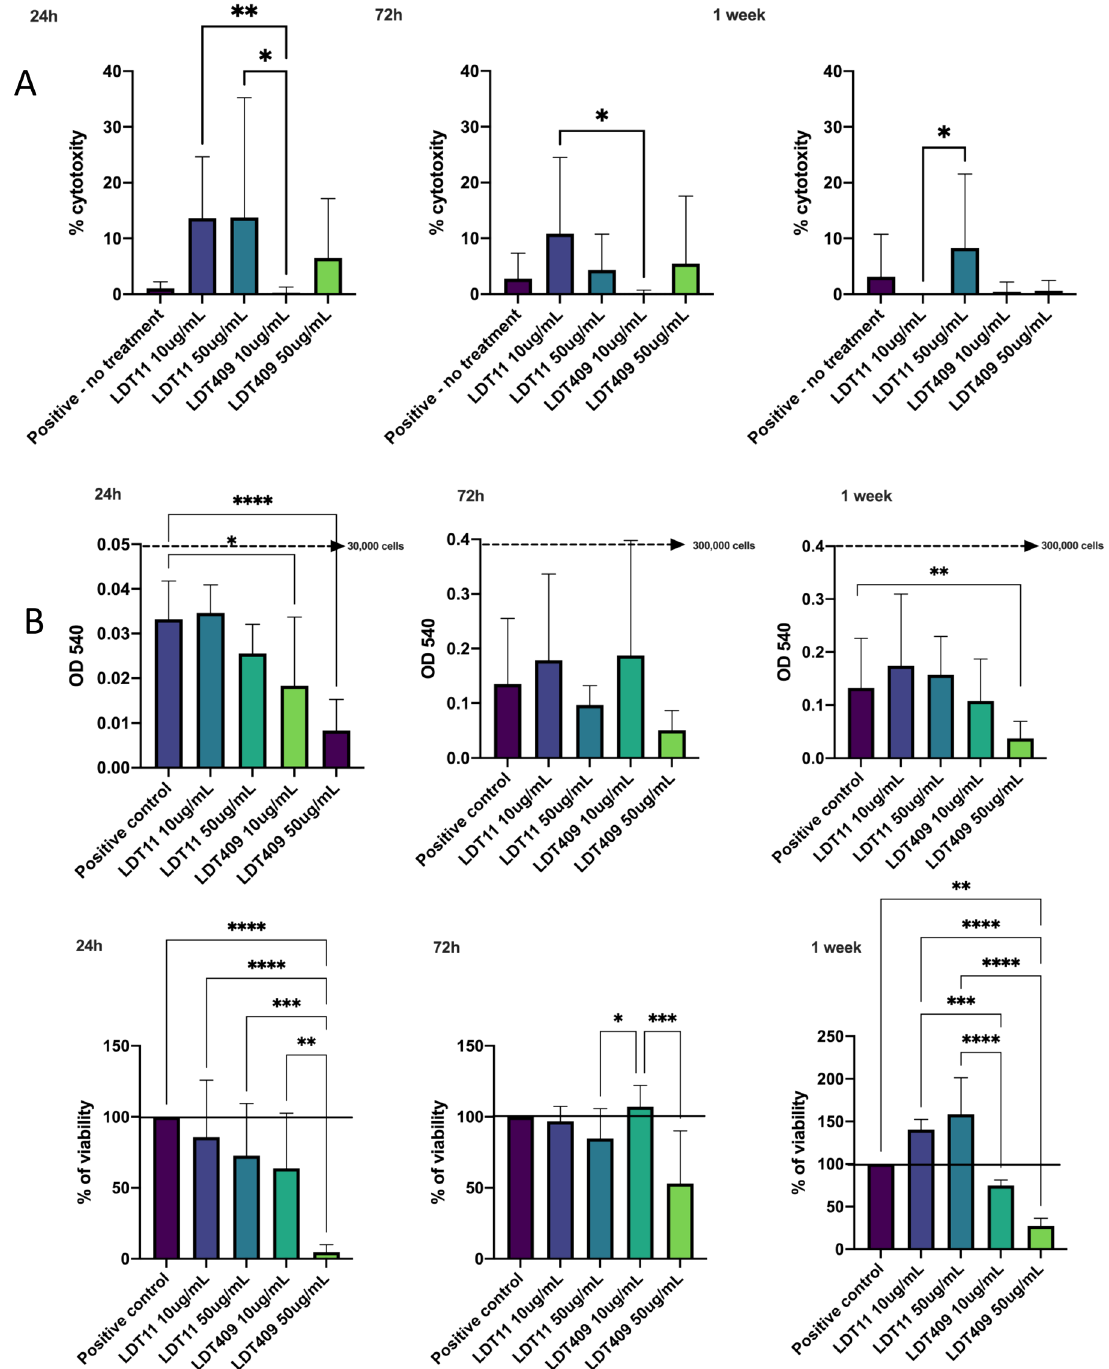
Figure 5. Biocompatibility of CNSL-derivatives LDT11 (anacardic acid-derivative) and LDT409 (cardanol- derivative). ( A ) Percentage of dead cells by LDH assay. Kruskal–Wallis with Dunns’s multiple comparisons results are shown as *p < 0.05, **p < 0.01, ***p < 0.001, representing paired comparisons. ( B ) Optical density at 540 nm and the proportion of viability by MTT assay. Dotted line represents the approximate number of cells based on the dose–response curve. The continuous line represents the 100% (cells with no treatment— positive control). Kruskal–Wallis with Dunns’s multiple comparisons results are shown as *p < 0.05, **p < 0.01, ***p < 0.001, ****p < 0.0001, representing comparison between the tests and positive control group (untreated cells under basal